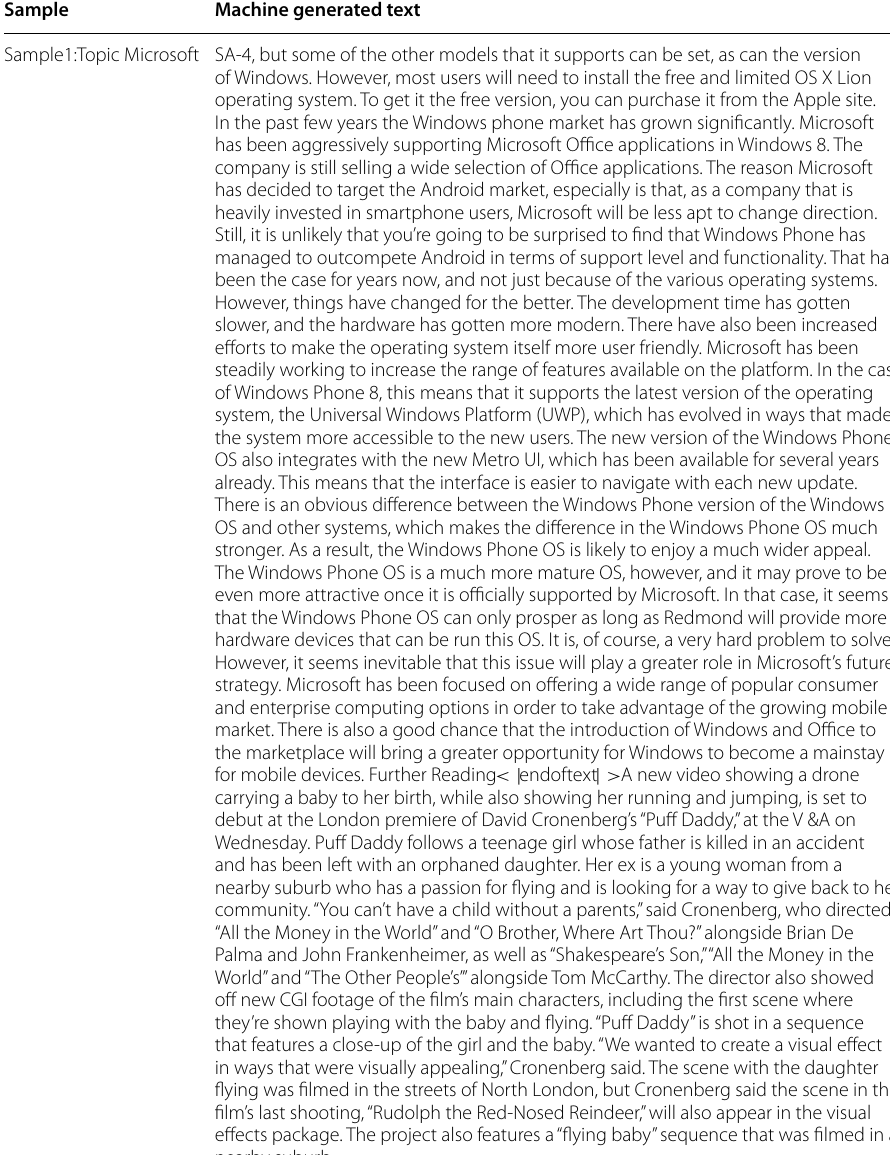
Table 7 Results of non-conditional samples Sample Machine generated